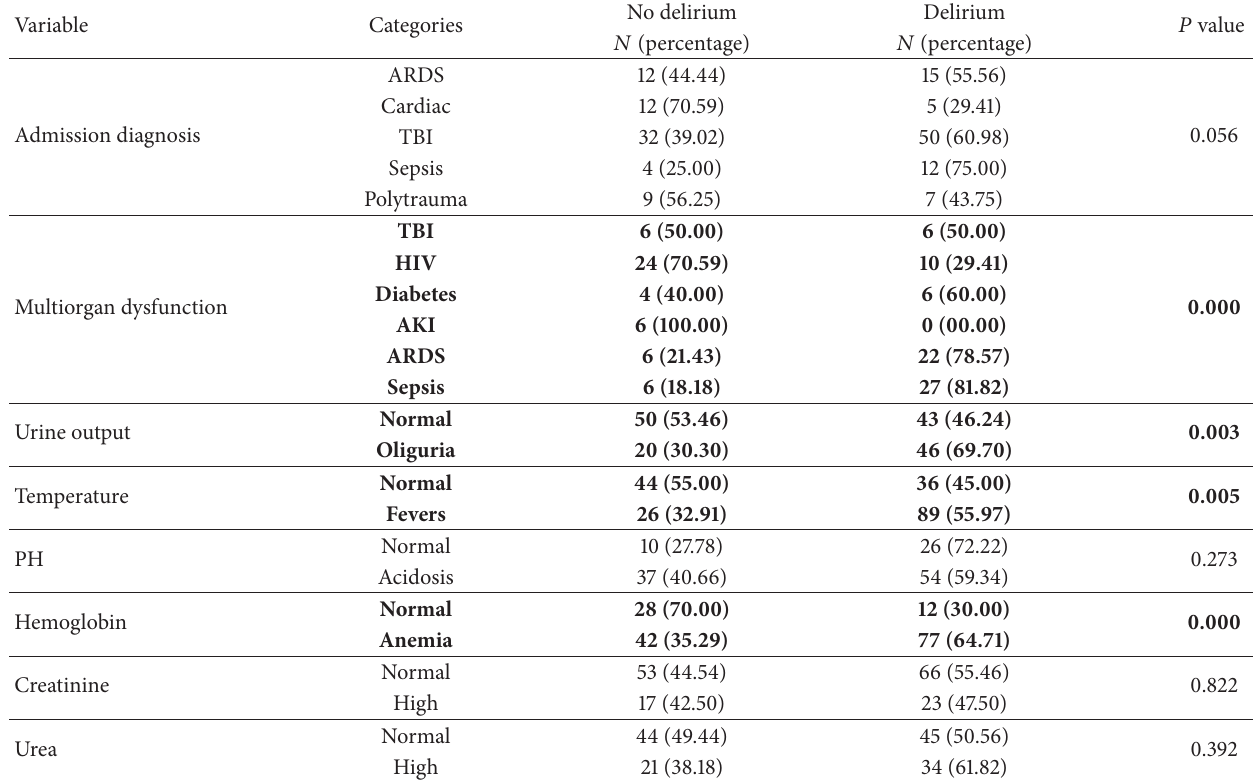
Table 2: Baseline admission